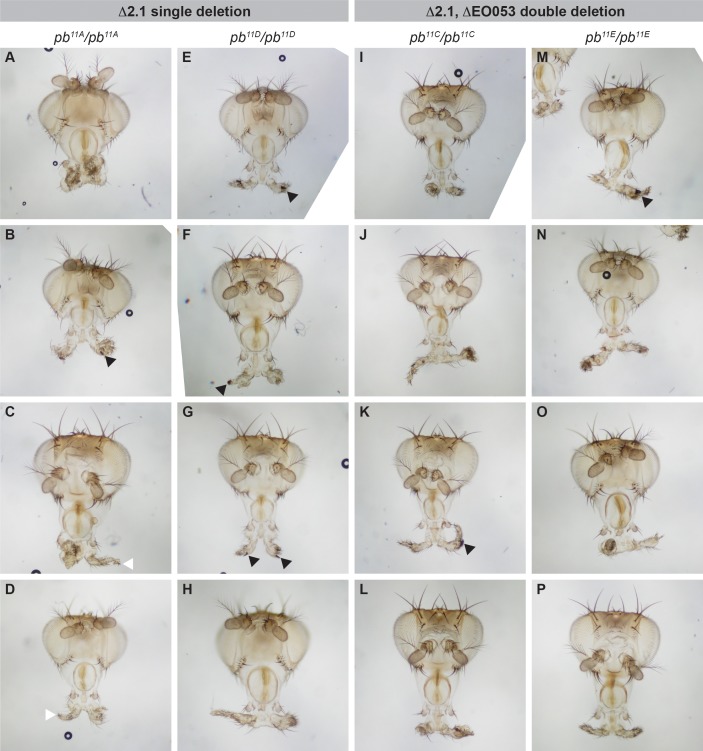
Deletion of region 2.1 is sufficient to cause a proboscis-to-leg transformation.Representative adult heads collected from flies homozygous either for a region 2.1 deletion (pb11A, (A–H) or for a double-deletion of region 2.1 and EO053 (pb11C, (I–P). Black arrowheads denote the presence of male sex combs, while white arrowheads point to terminal claws.